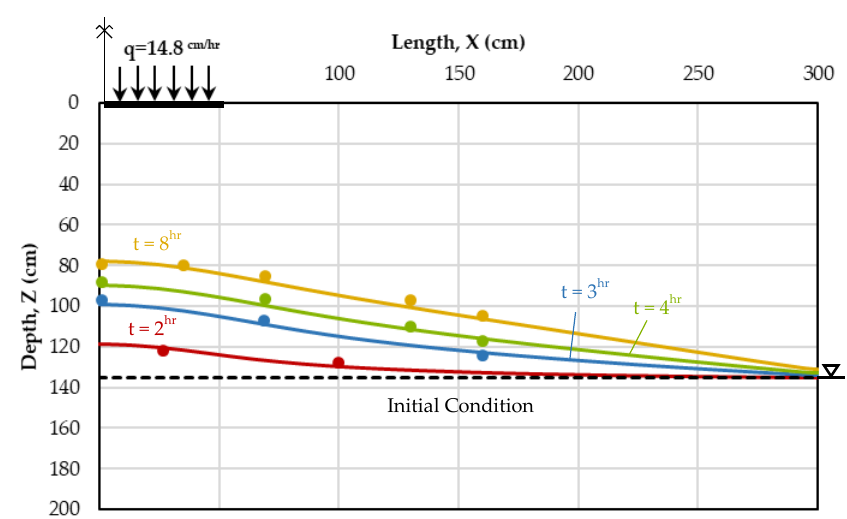
Figure 12. Result of 2-D water table recharge example.